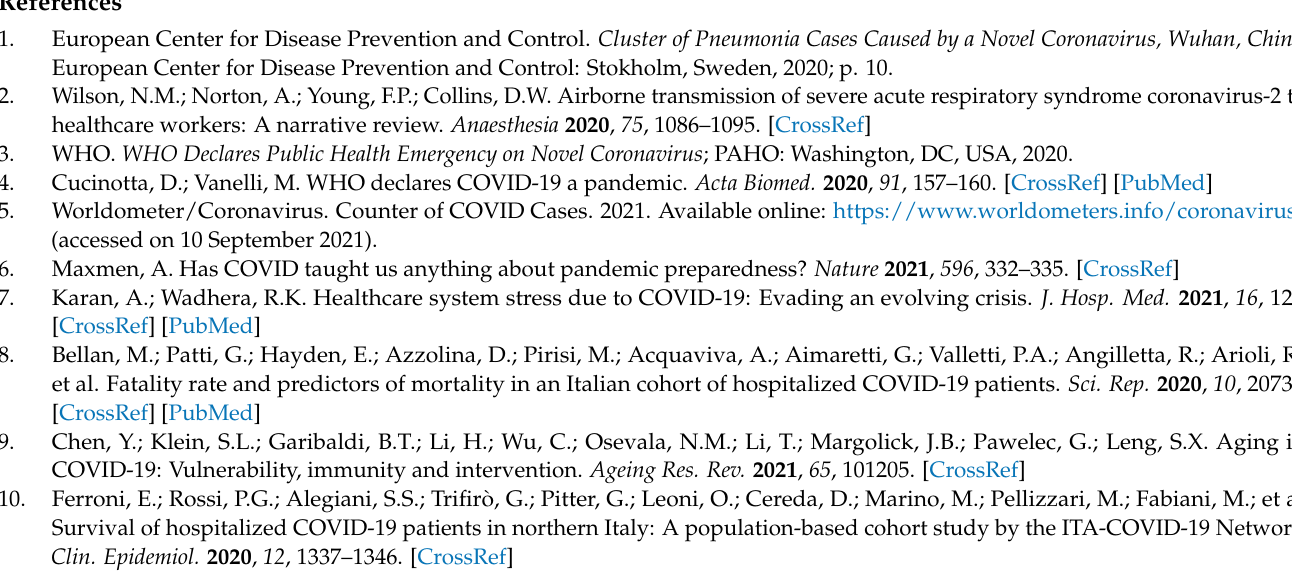
Table S3: Prognostic factors associated with hospitalized cases for COVID-19 with multimorbidity in the state of Hidalgo in